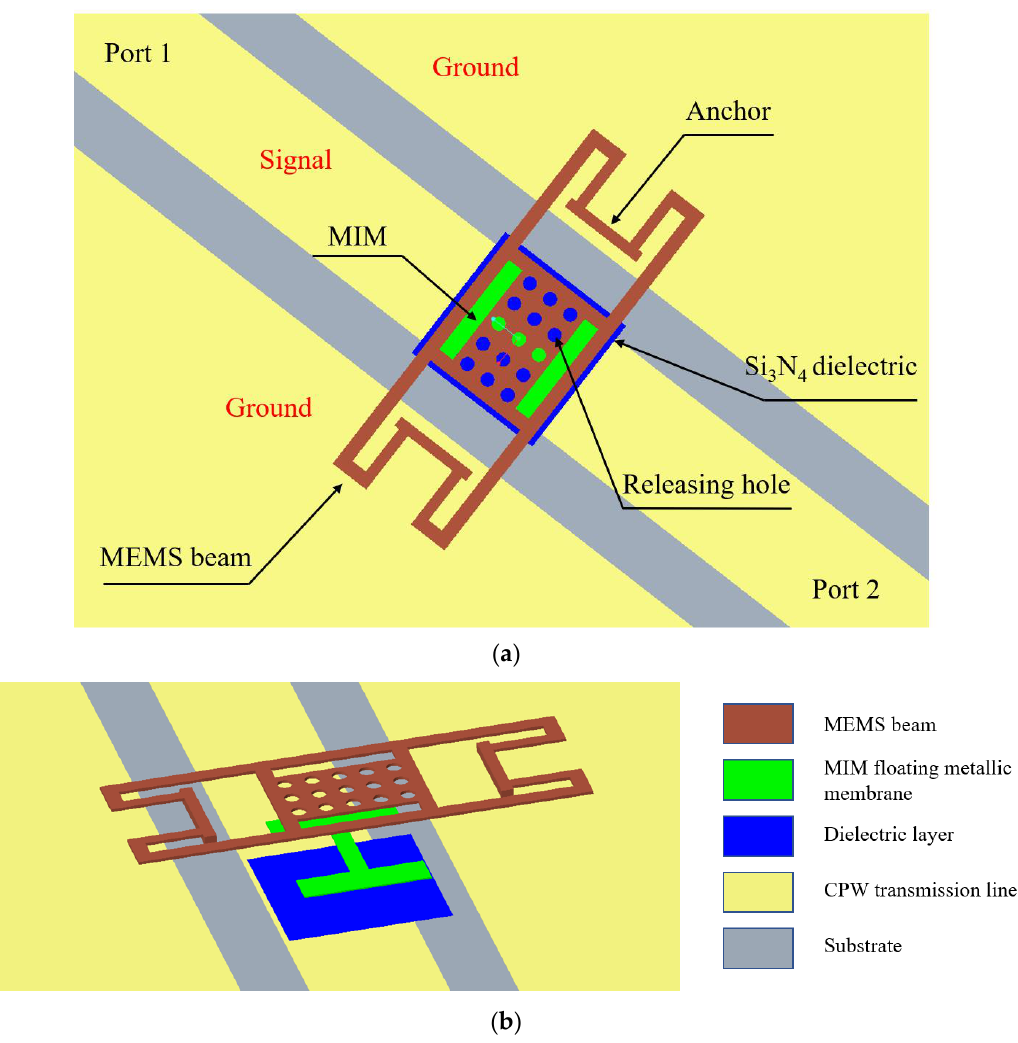
Figure 10. ( a ) The top view of the proposed MEMS switch; ( b ) The dismantled figure of the proposed MEMS switch.